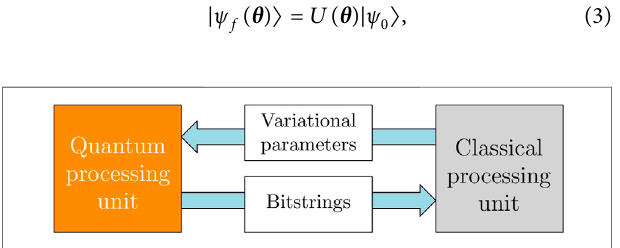
FIGURE 1 | (Colour online) Schematic of the hybrid quantum-classical mechanism of a variational quantum eigensolver.